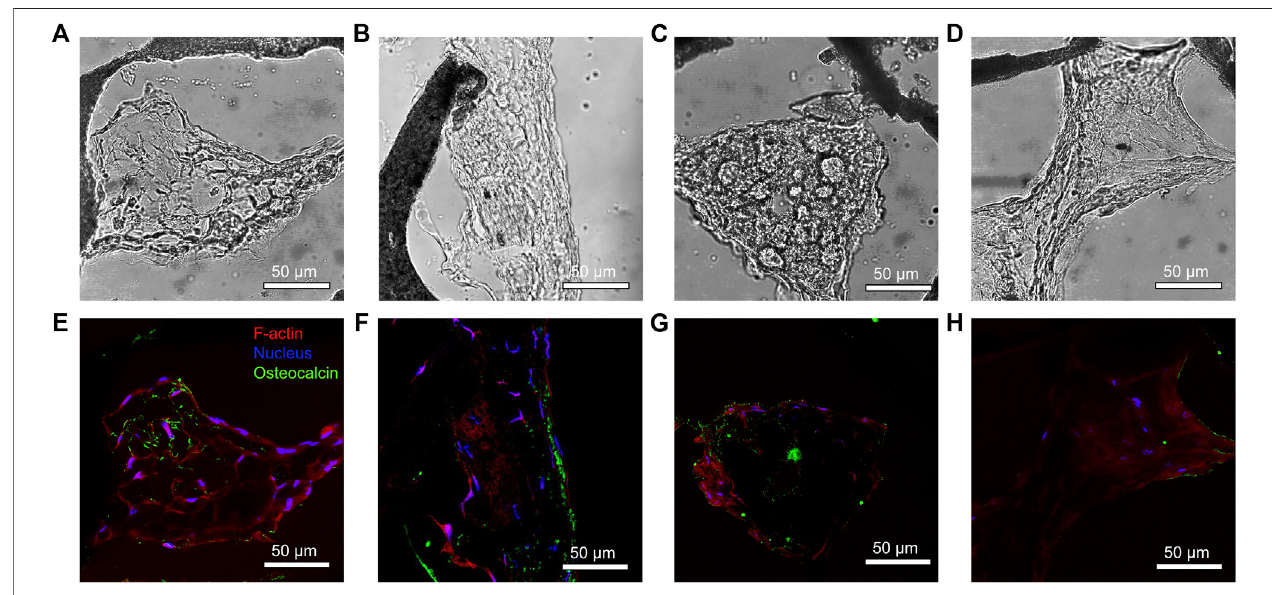
FIGURE4| Osteogenicdifferentiationofstemcells. (A-D) Bright fi eldlaserscanningconfocalmicroscopyimagesof (A) B1H9, (B) B3H7, (C) B1H1,and (D) B9H1 sections. (E-H) Correspondingimagesofosteocalcinimmunostaining.Horizontalscaffoldsectionsweretakenfromthetop300 µmofthescaffolds.N=2sampleswere sectioned for each group.